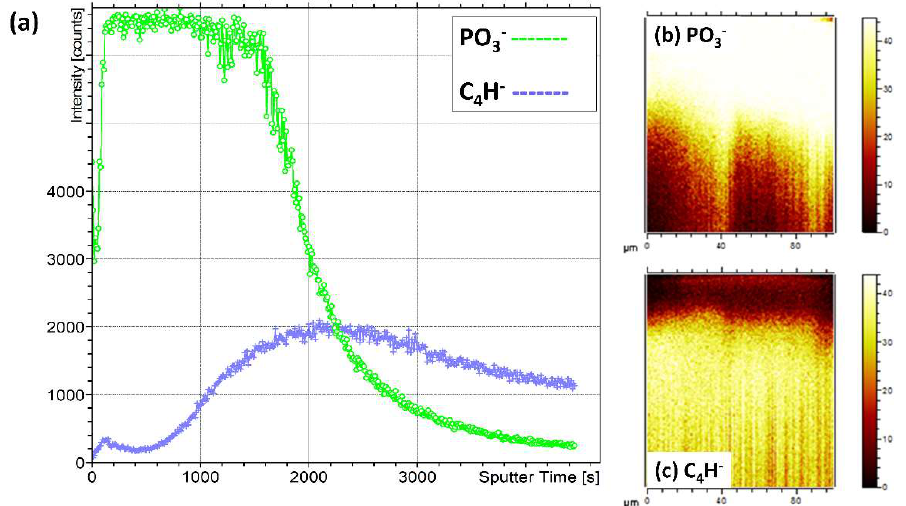
Figure 16. ( a ) ToFSIMS depth profile for PO 3− and C 4 H − ions, with 2D images for ( b ) the PO 3− and ( c ) the C 4 H − ions.